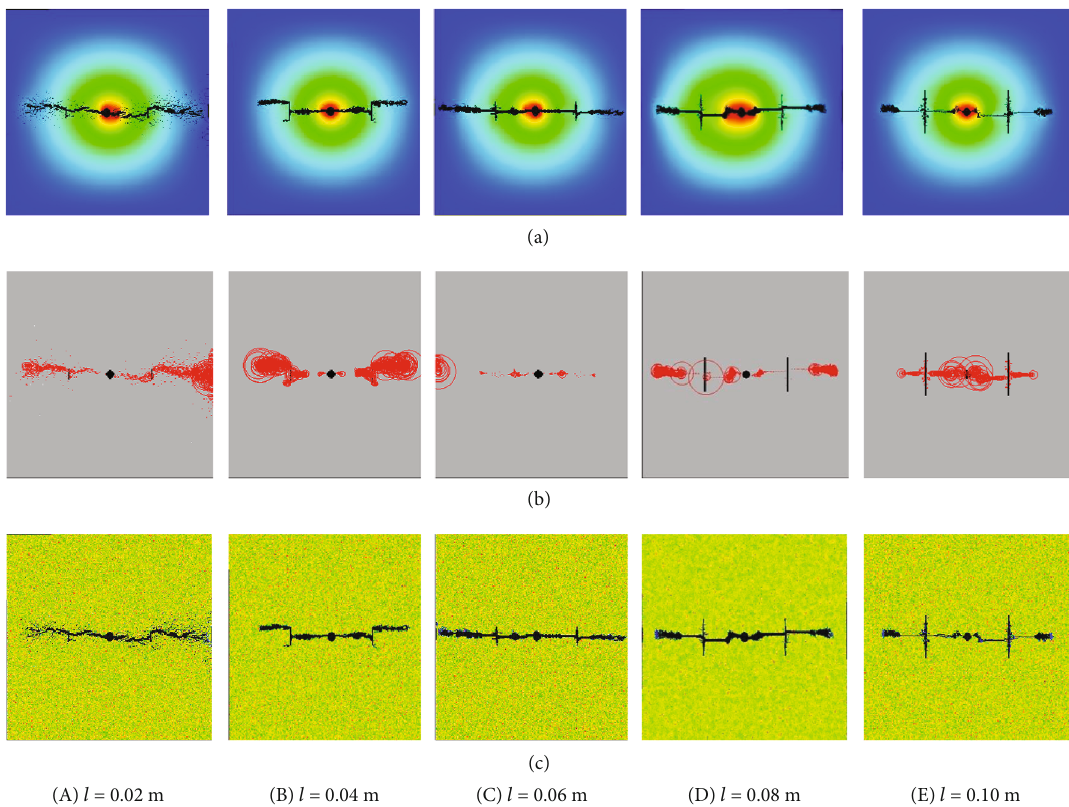
Figure 9: Process of hydraulic fracture propagation under di ff erent natural fracture lengths l . (a) Cloud map of the pore water pressure. (b) Acoustic emission signal. (c) Morphology of the hydraulic fracture propagation.